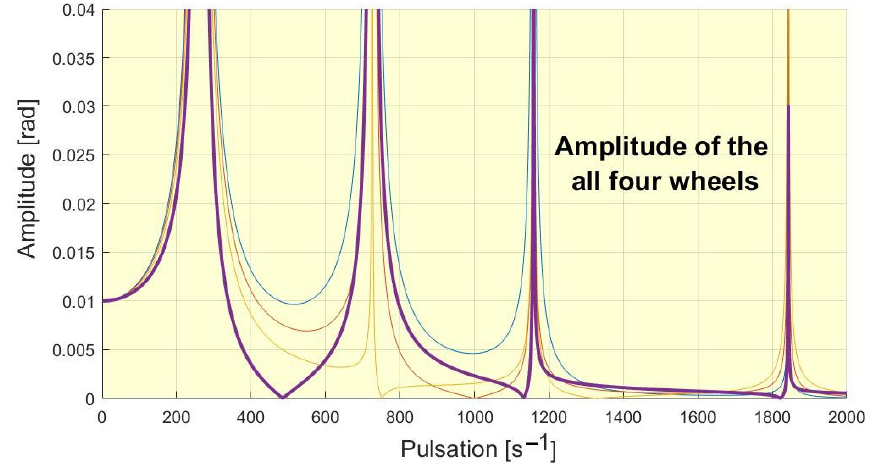
Figure 13. The amplitudes of the flywheels for the simplified system overlapped.